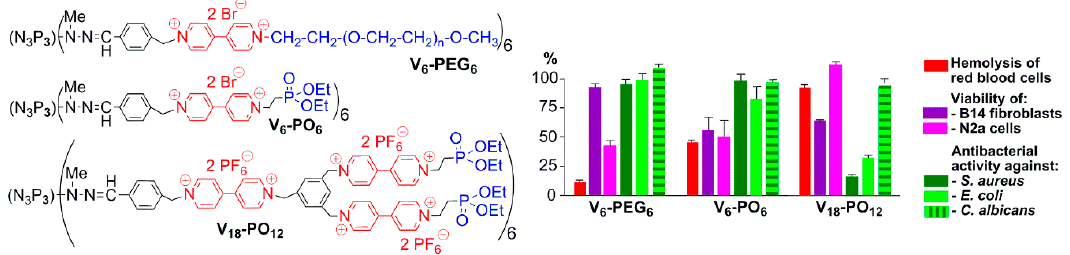
Figure 11. Examples of dendrimers incorporating viologen units in their structure, and some of their biological properties.